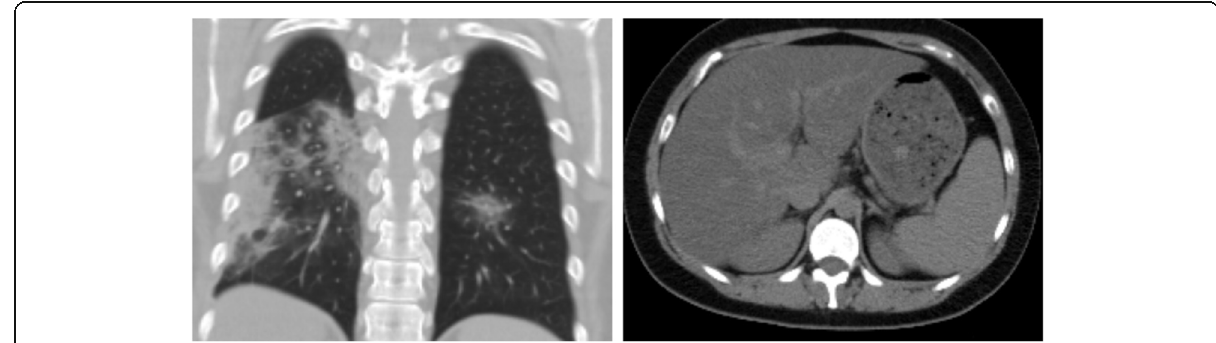
Fig. 2 Female patient, 28 years old. CT chest shows multiple pulmonary ground-glass opacities mounting to consolidative patches, reported as CORADs 5. Upper abdominal cuts show diffuse low parenchymal attenuation of the liver denoting fatty